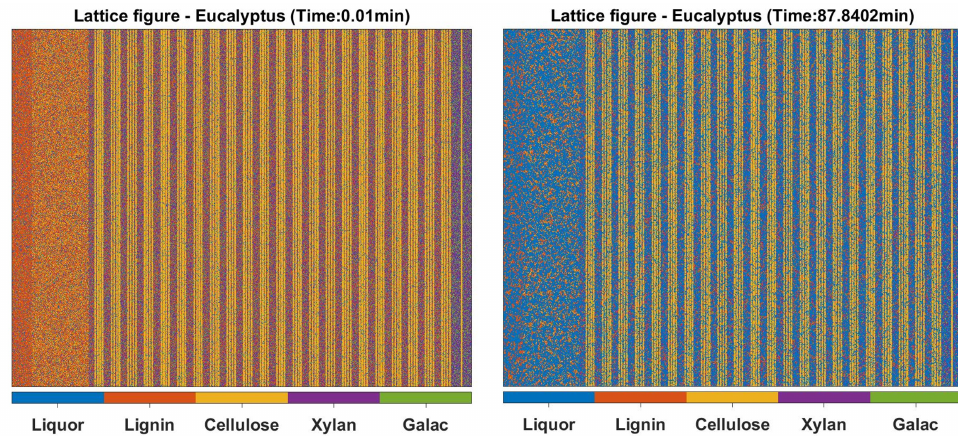
Figure 4. Graphical illustration of the simulation lattice at t = 0 and t = 87.84